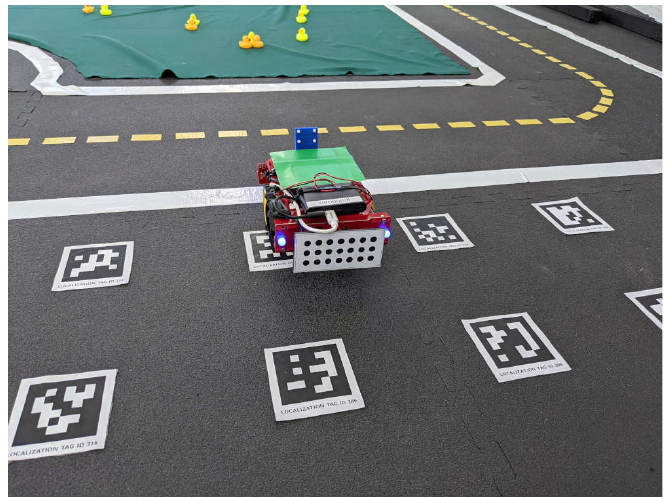
Figure 5. Markers’ locations for moving the robot out of the calibration